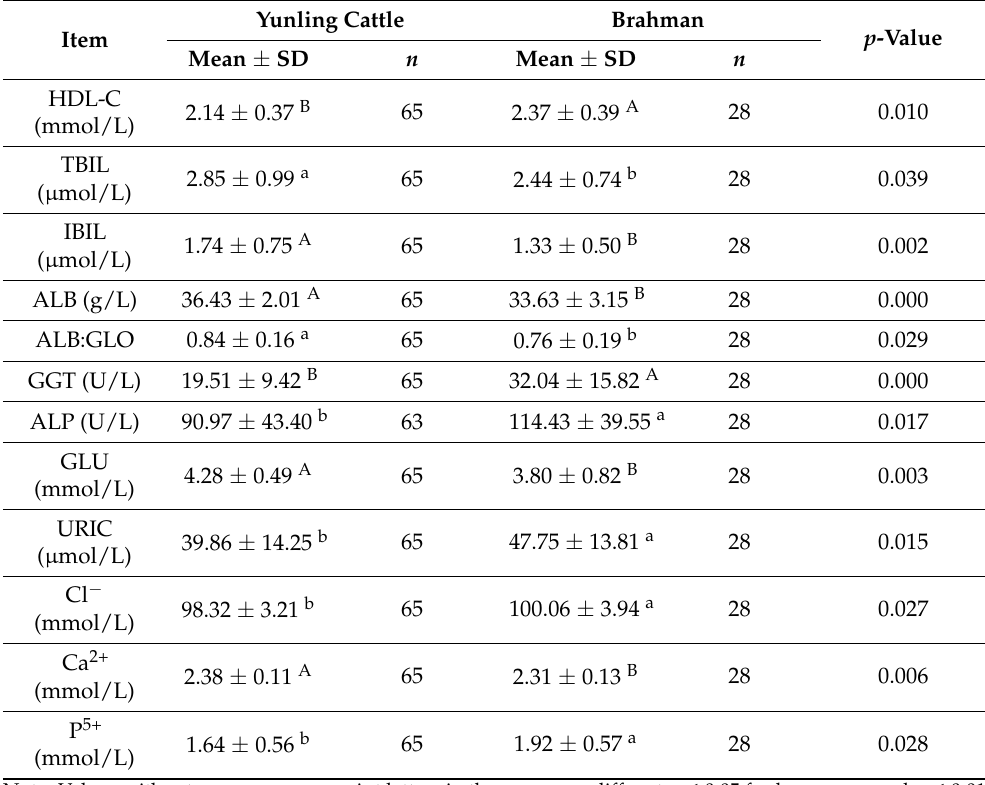
Table 4. The blood biochemical indicators of Brahman and Yunling cattle. Yunling Cattle Item